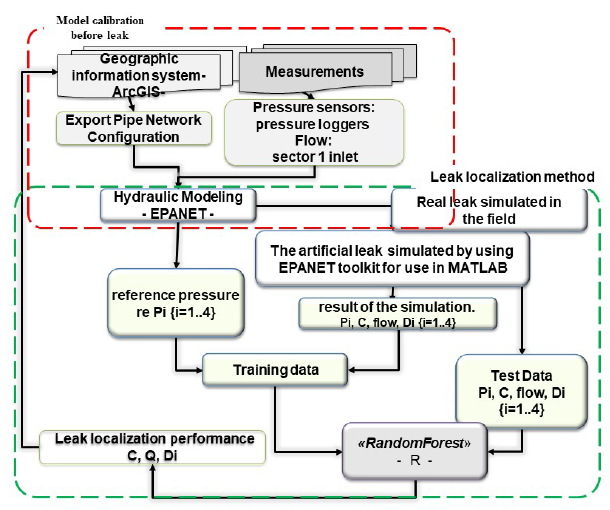
Figure 6. Leak prelocalization procedure.